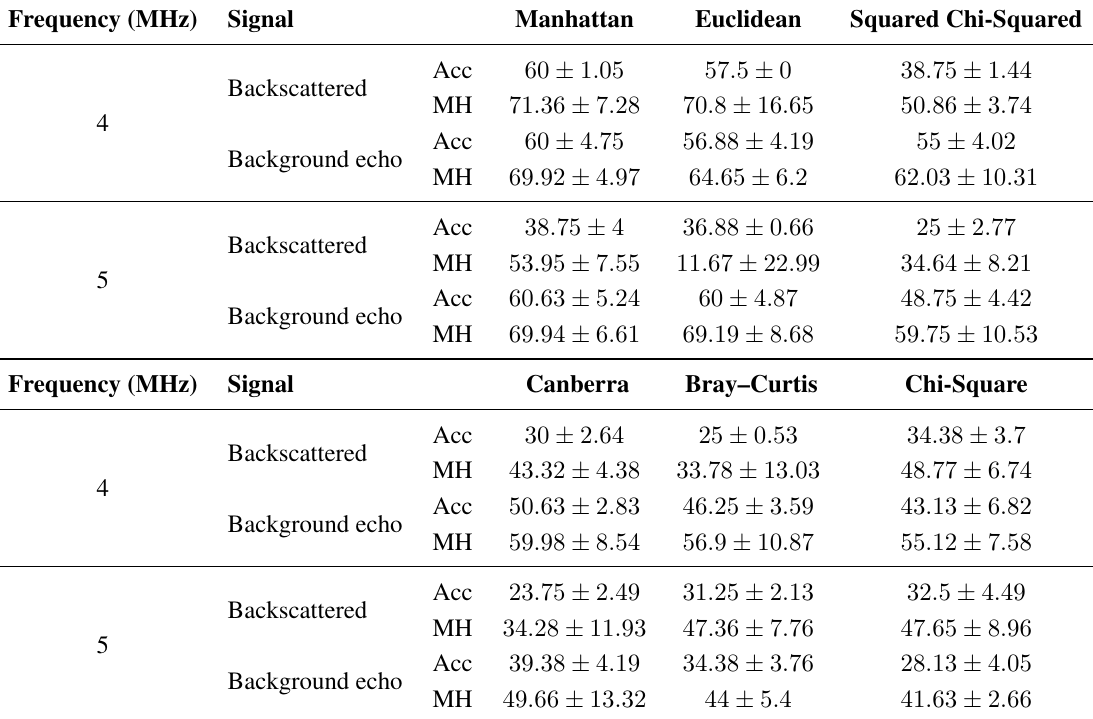
Table 7. Accuracy rates and harmonic mean for the 4- and 5-MHz frequency at 950 ◦ C. Frequency (MHz) Signal